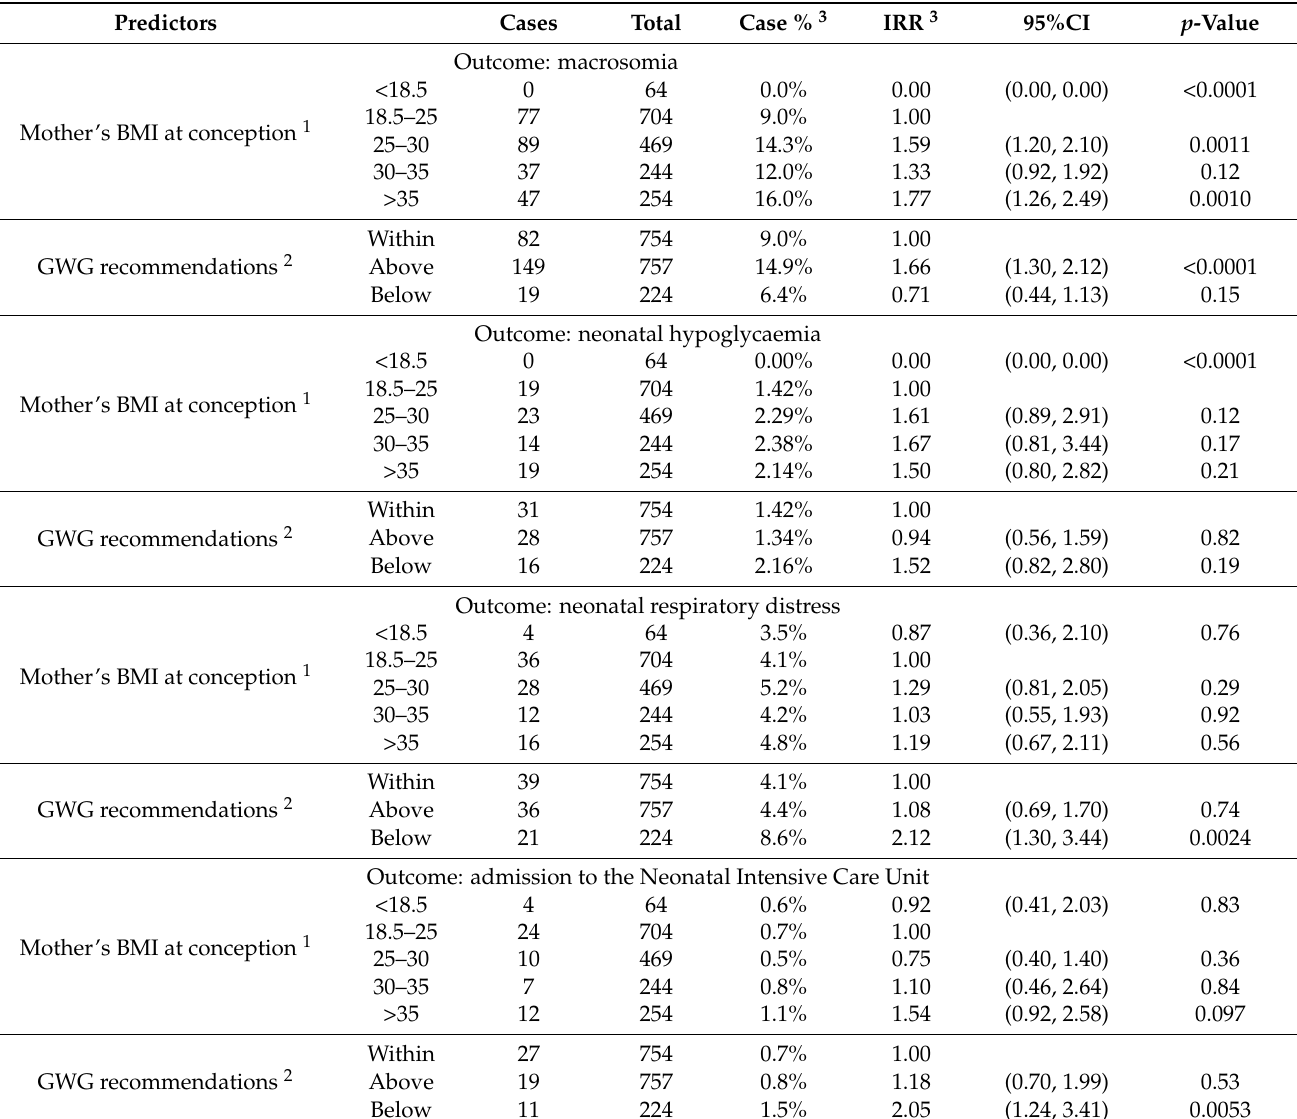
Table 5. Neonatal complication associated with from BMI and GWG